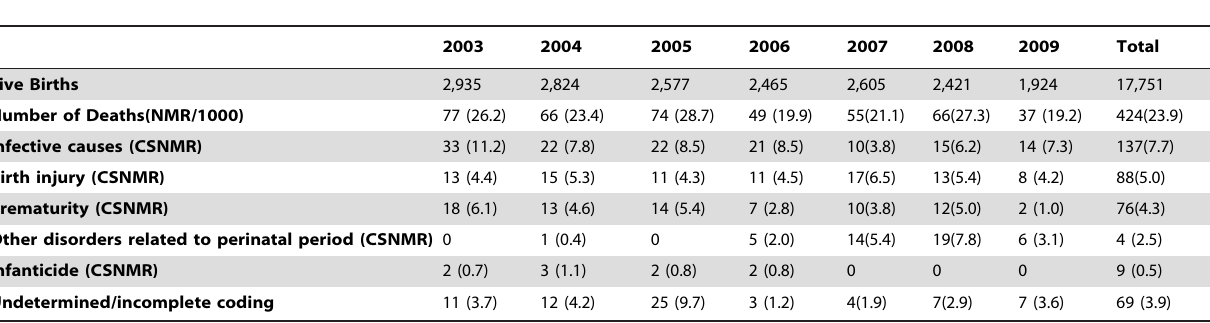
Table 1. Neonatal Mortality Rates and Leading Causes of Deaths in Kassena-Nankana District, Ghana